Question: What visual encoding does this figure use to show its data?
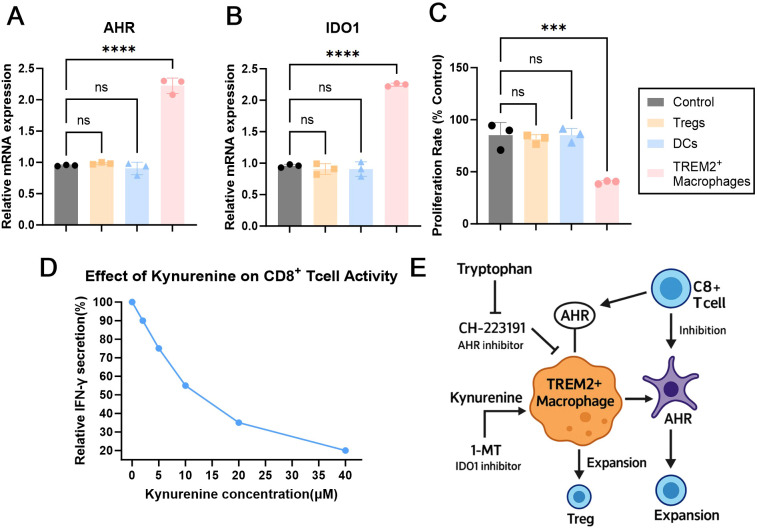
Answer: line